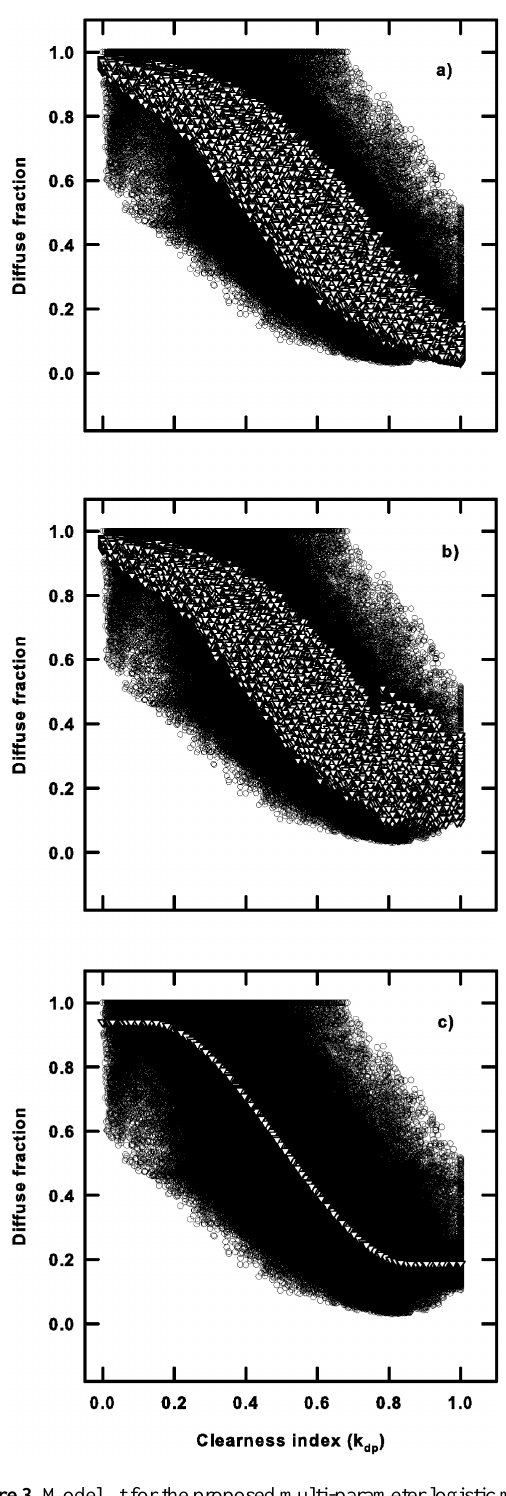
Figure 3. Model fit for the proposed multi-parameter logistic model ( a and b ) and cubic model (c) . Panel (a) represents the initial fit to the logistic form and panel (b) indicates the modification to the initial logistic fit with a second logistic